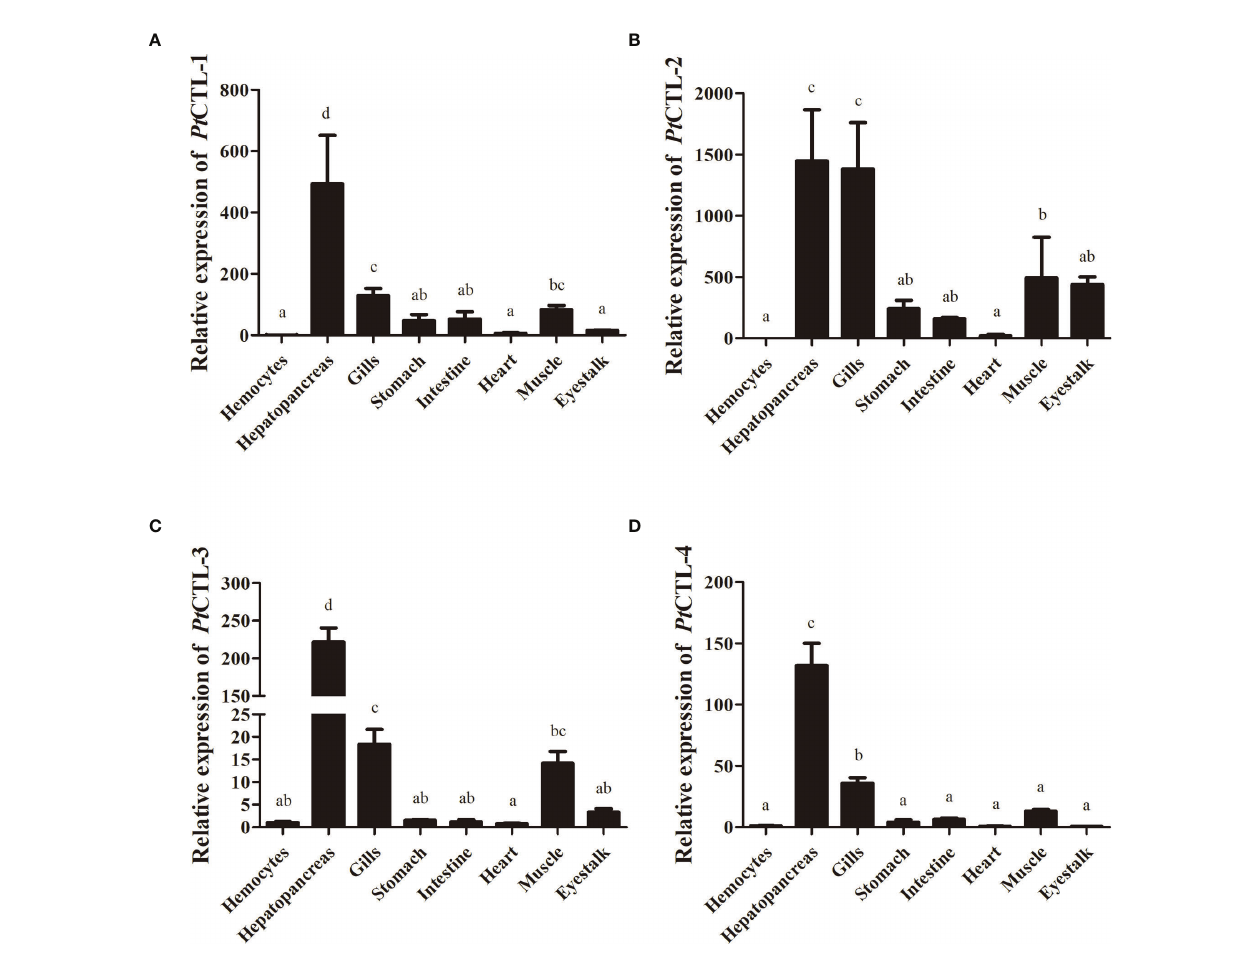
FIGURE 5 | Spatial expression analysis of PtCTLs in different tissues. (A) PtCTL-1; (B) PtCTL-2; (C) PtCTL-3; (D) PtCTL-4. Expression levels in hepatopancreas, gills, stomach, intestine, heart, muscle and eyestalk are normalized to those in the hemocytes, and b -actin is used as a reference gene. Vertical bars represent the means ± SD, n = 5. Results were analyzed by one-way ANOVA and different letters (a-d) above the bars presented signi fi cant differences between groups (p <